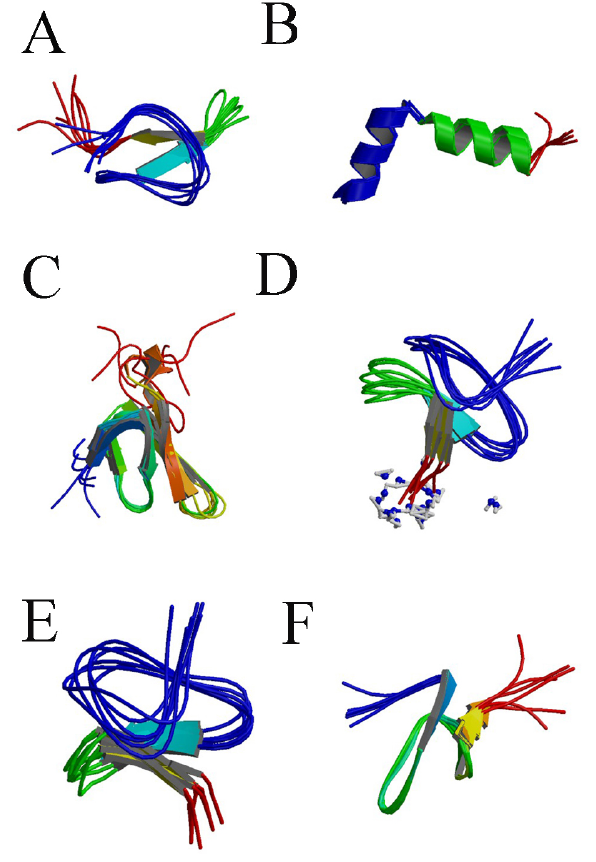
Figure 1. The 3D structure of spider venom peptides. ( A ), PcTx1(Psalmotoxin1, PDB ID: 1LMM); ( B ), Latarcin 2a (PDB ID: 2G9P); ( C ), ω-agatoxin-IVA (PDB ID: 1IVA); ( D ), HNTX-IV (Hainantoxin-IV, PDB ID: 1RYG); ( E ), HWTX-IV (Huwentoxin-IV, PDB ID: 1MB6); ( F ), ProTx-II (PDB ID: